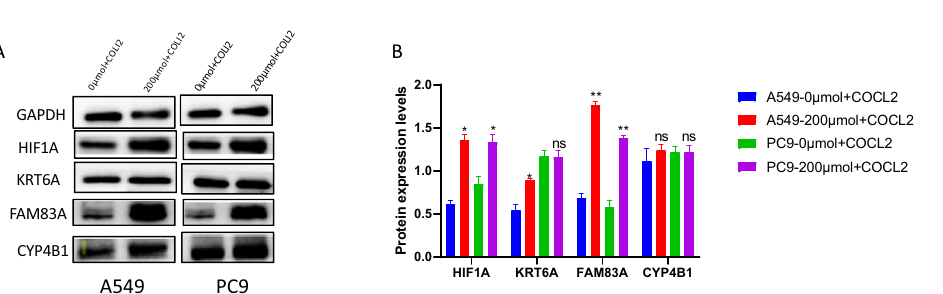
Figure 10. ( A , B ) CoCl2 induced hypoxia and normal environment, the expression level of risk genes (KRT6A, FAM83A and CYP4B1) and